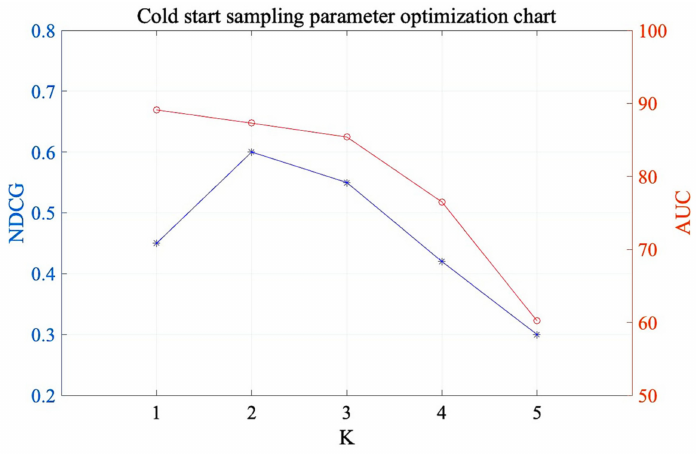
Figure 8. Cold-start sampling parameter optimization